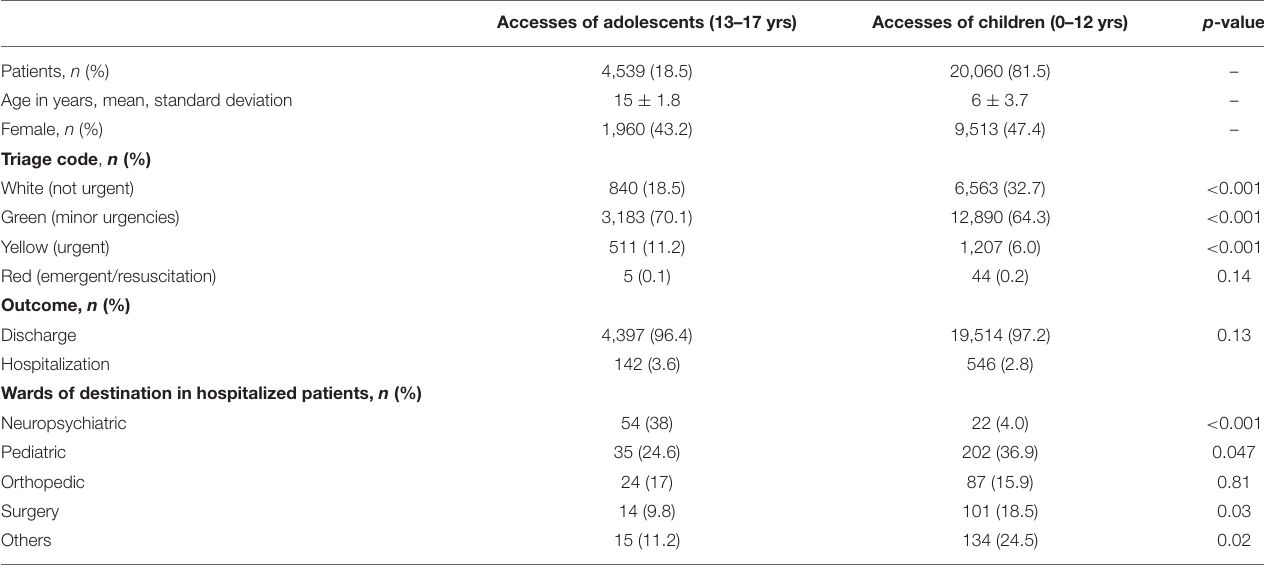
TABLE 3 | Outcomes of adolescents compared to children accessing to the